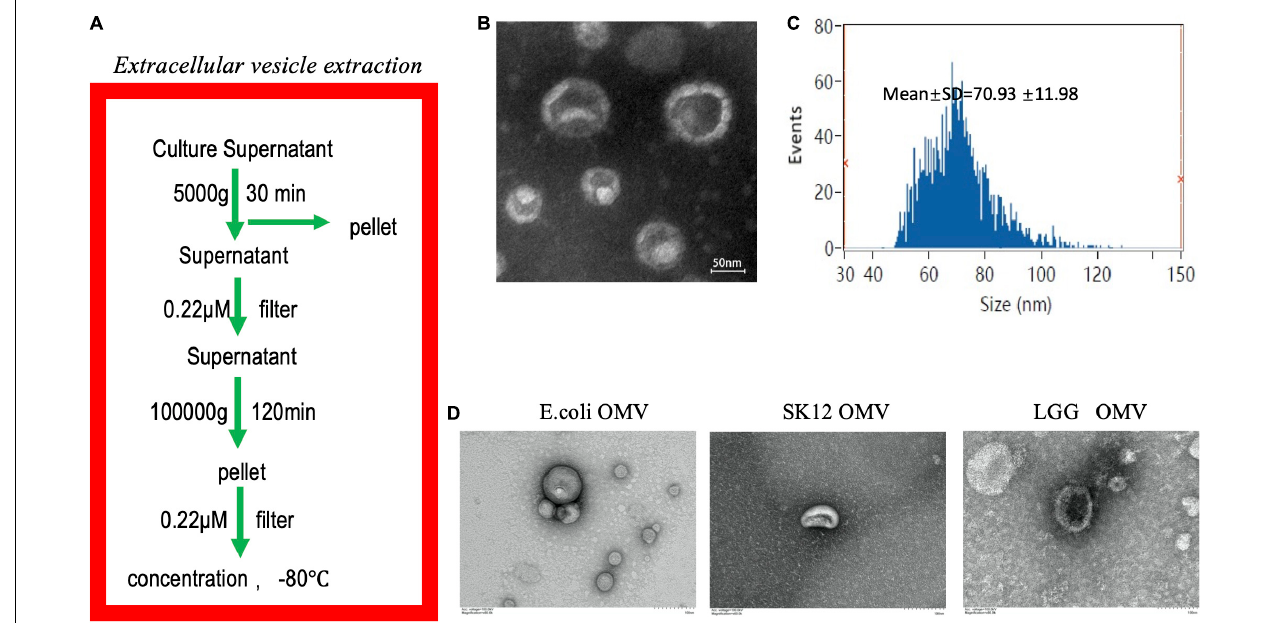
FIGURE 1 | Extraction and identification of F. nucleatum OMVs. (A) Extraction of F. nucleatum OMVs by ultracentrifugation followed these steps. (B) F. nucleatum OMVs were observed by TEM and exhibited a similar tray structure. (C) NTA showed that the OMVs ranged in size from 62–310 nm, with a peak at 131 ± 25 nm. (D) The OMVs of E. coli , S. salivarius K12 and L. rhamnosus GG were extracted via a similar method and showed different